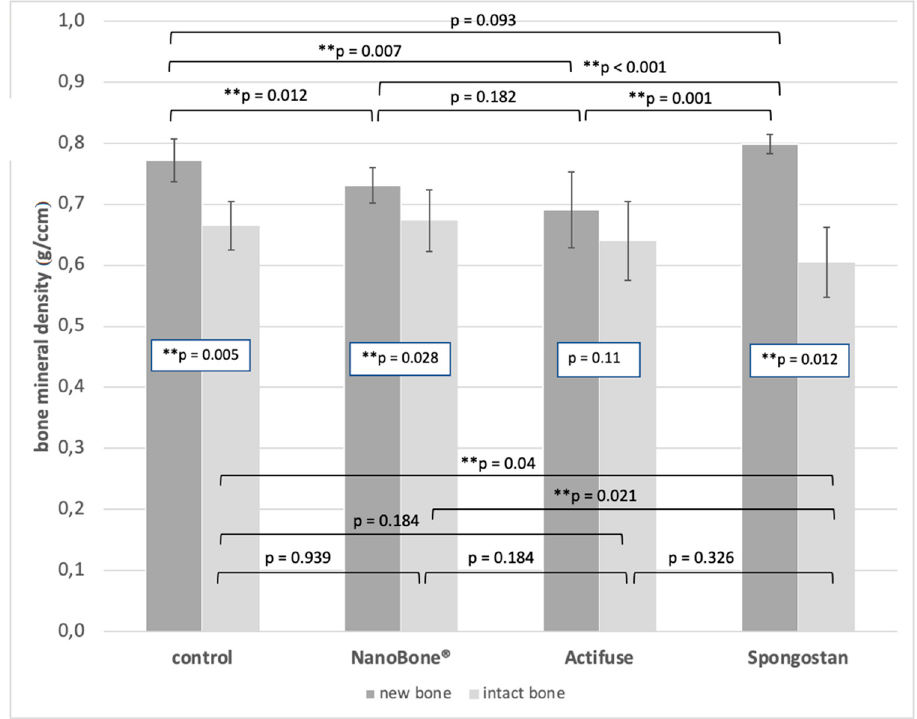
Figure 5. Diagram showing the bone mineral density of the new bone and the intact bone with respect to the treatment groups. p -values for the comparison new vs. intact bone are shown within the bars. Significant differences between the groups are marked (*) above the bars.